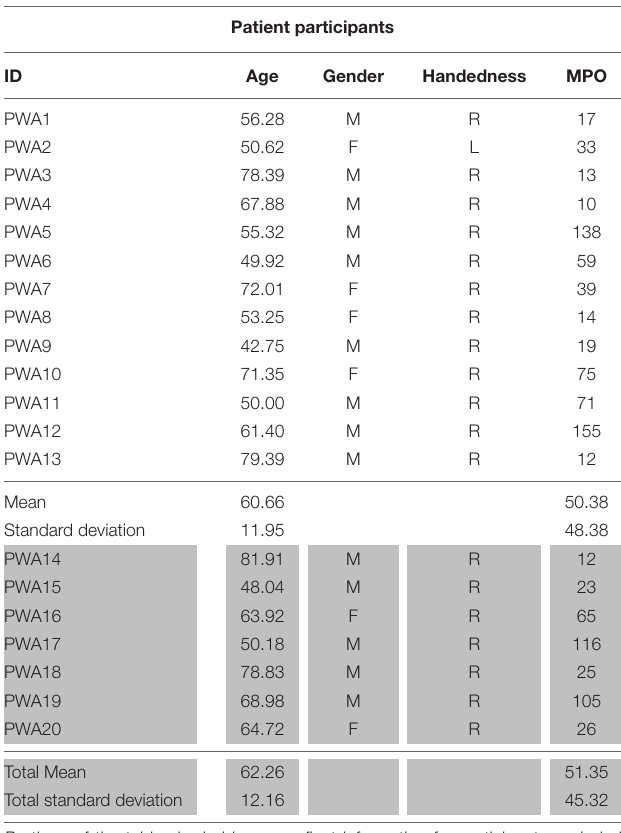
TABLE 1A | Demographic information for PWA including age, gender, handedness, and months post onset of CVA (MPO). Patient